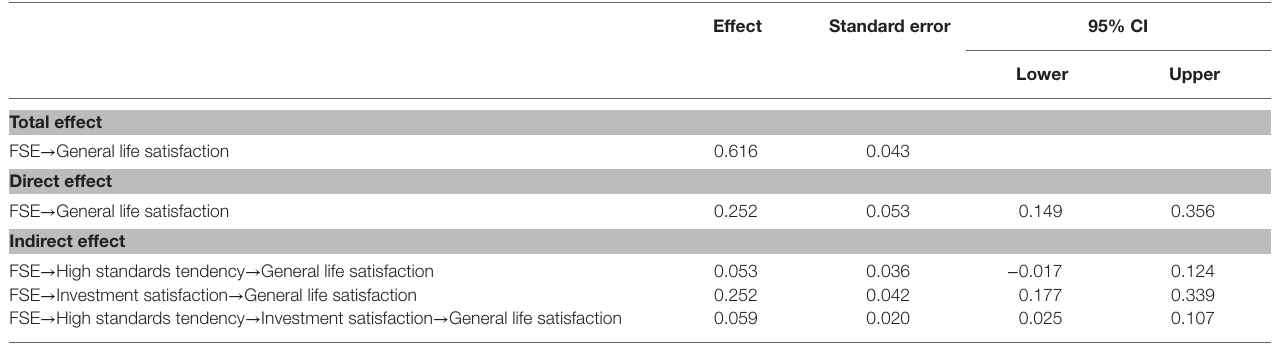
TABLE 3 | Total, direct, and indirect effects of financial self-efficacy on general life